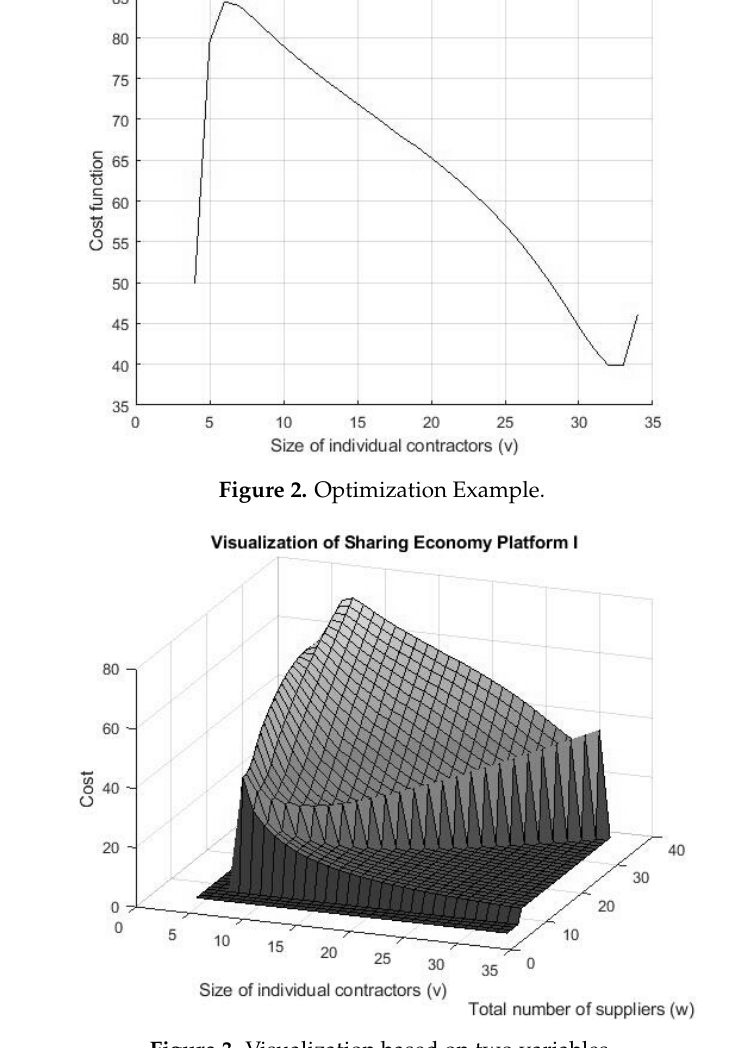
Figure 3. Visualization based on two